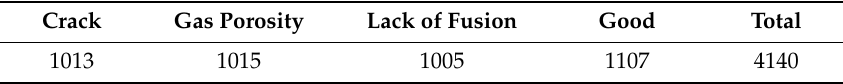
Figure 1. Examples of laser metal deposition (LMD) build parts quality optical images: ( a ) good quality, ( b ) crack, ( c ) gas porosity, and ( d ) lack of fusion with a resolution of 224 × 224 pixels. Table 2. The number of images in each category.